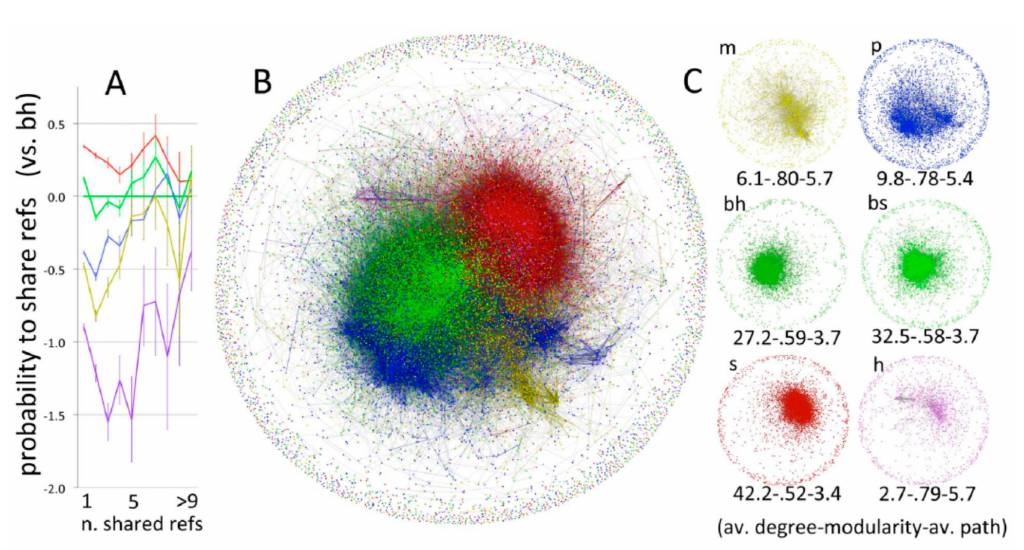
Figure 8. Maps of science of from Fanelli and Glänzel [34] showing probability of sharing references ( A ); network of shared references ( B ) and networks by domain ( C ). Bibliographic coupling network of papers, partitioned by scientific domain (total N = 28,477; yellow = mathematics; blue = physical sciences; darker green = biological-hard sc.; lighter green = biological-soft sc.; red = social sc.; purple =